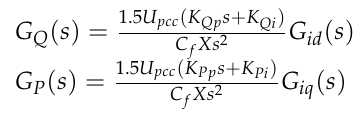
Figure 5. Block diagram for PQ ( real and reactive power ) control.